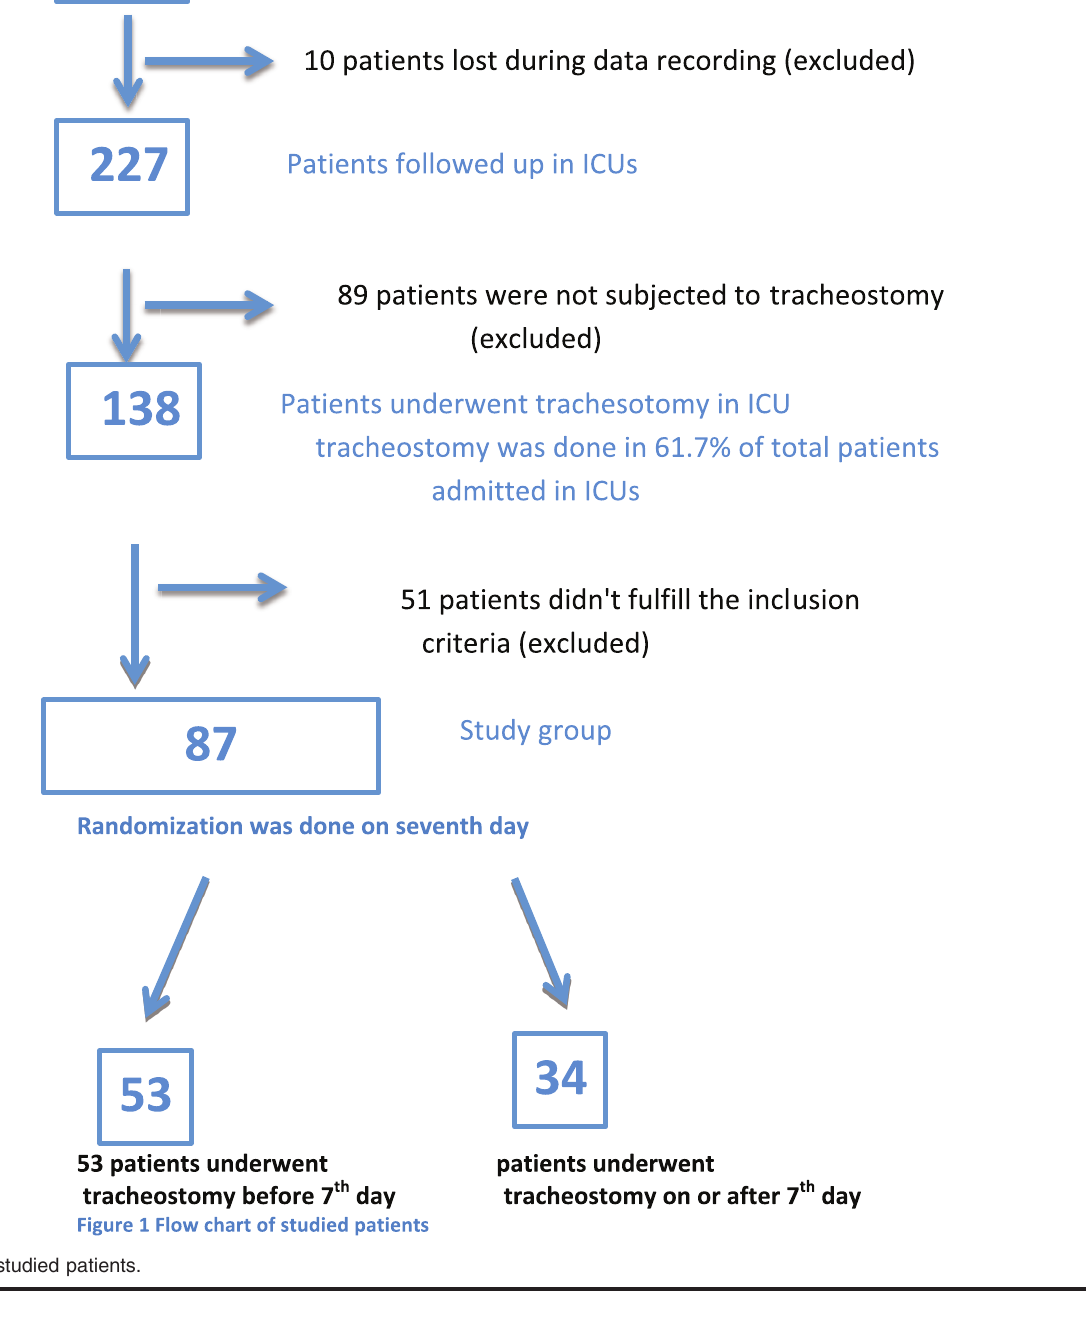
Table 1 Demographic and clinical data of the patients in early tracheostomy and late tracheostomy groups